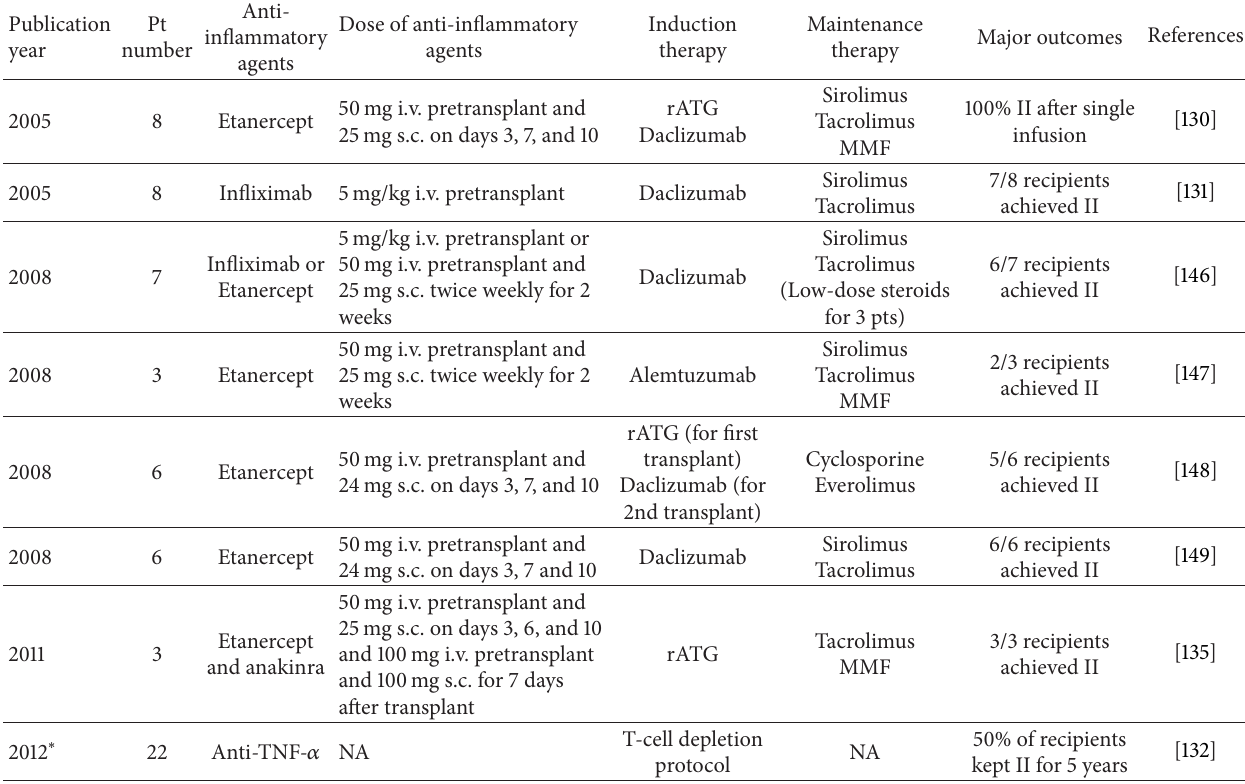
Table 1: Anti-inflammatory agents in clinical allogeneic islet cell